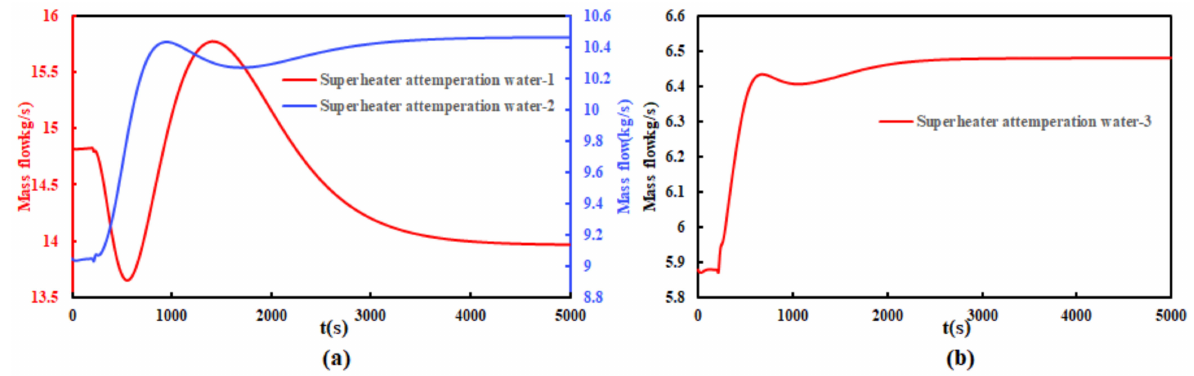
Figure 13. Temperature response when total air mass flow decreased by 5%: ( a ) the steam temperature of the water wall outlet and LTS outlet; ( b ) steam temperature of ITS and HTS outlet; ( c ) steam temperature of LTR outlet and HTR outlet; ( d ) bed temperature.